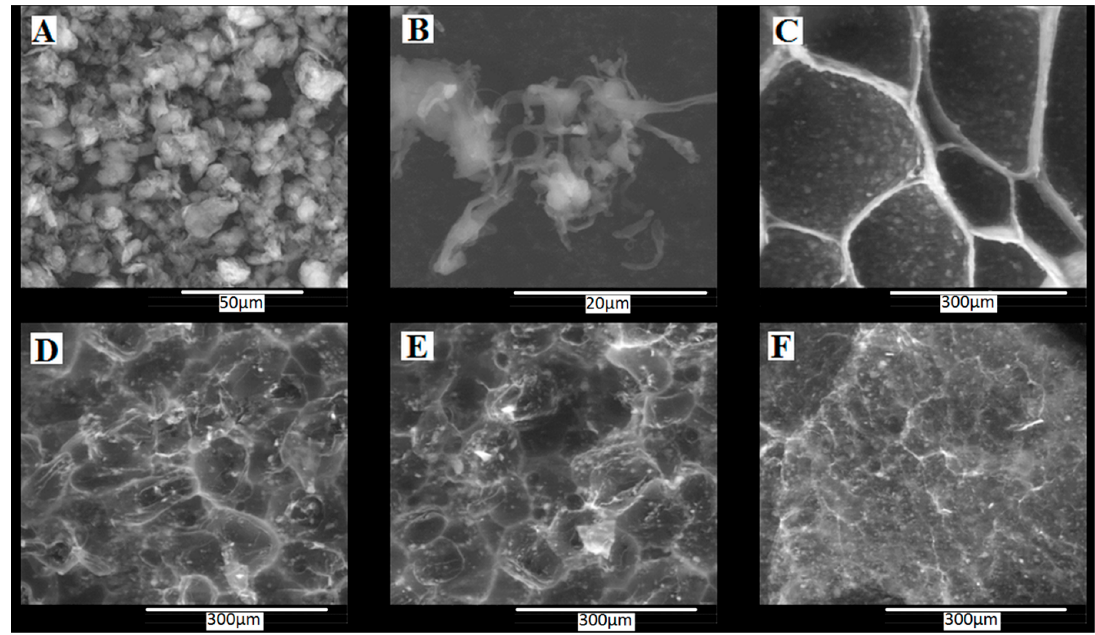
Figure 2. SEM images showing the morphology of several samples; ( A ) Cl 93A (×2000), ( B ) Salecan (×8000), ( C ) PC, ( D ) PCS1, ( E ) PCS2, ( F ) PCS3